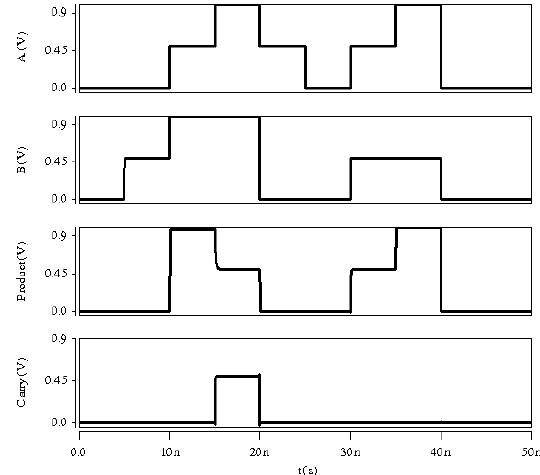
Figure 4. Transient responses of the proposed exact multiplier.